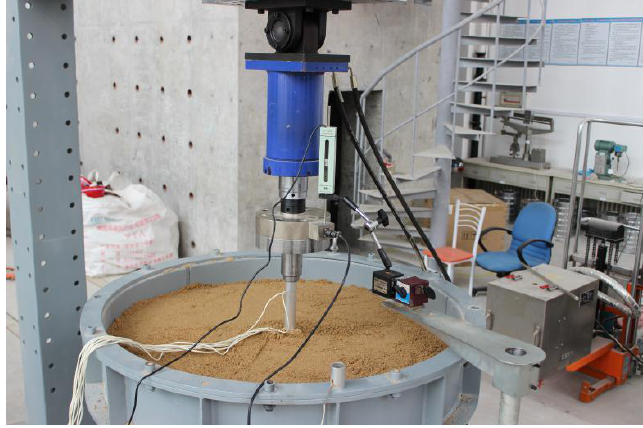
Figure 6. Dial indicator layout scheme.